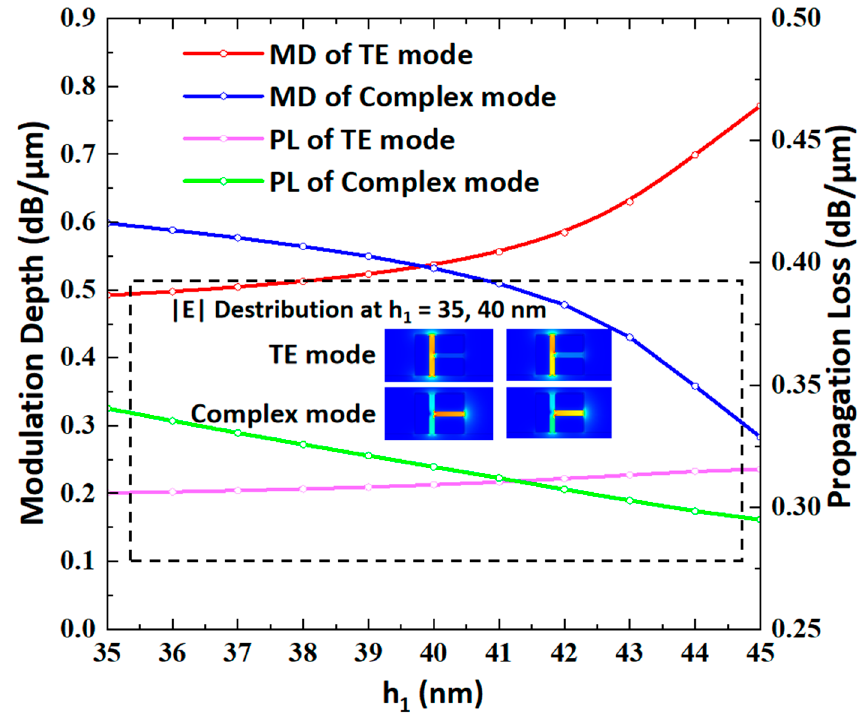
Figure 7. MD and PL of the TE mode and the complex mode as a changing relationship of h 1 .